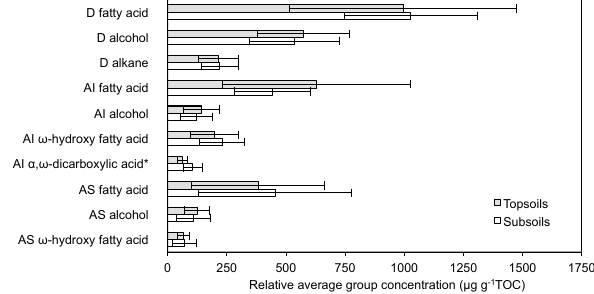
Figure 3. The relative average concentrations (µgg − 1 TOC) of compound groups in the topsoils and subsoils. Error bars repre- sent standard deviations of concentrations for compound groups. ∗ Means significant differences between topsoils and